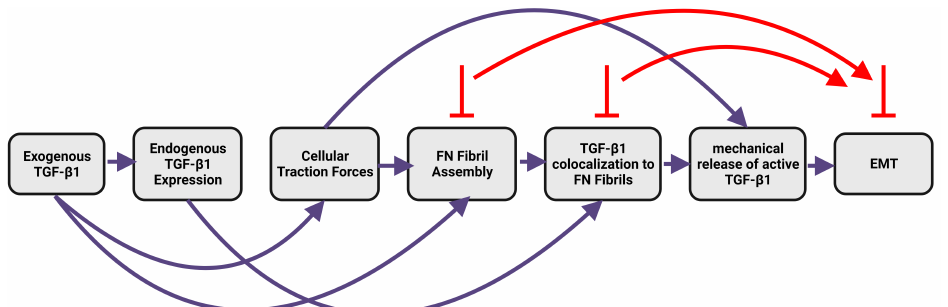
Figure 1. The relationship between TGF- β 1, fibronectin fibrillogenesis, and Epithelial-Mesenchymal Transition. Prior work has shown that TGF- β 1 induces upregulation of contractile forces [26], which in turn upregulate fibronectin fibrillogenesis [3,17]. Endogenous TGF- β 1 localizes to fibronectin fibrils [27] to promote EMT. Inhibition of either fibronectin fibrillogenesis or TGF- β 1 to fibronectin fibrils inhibits EMT